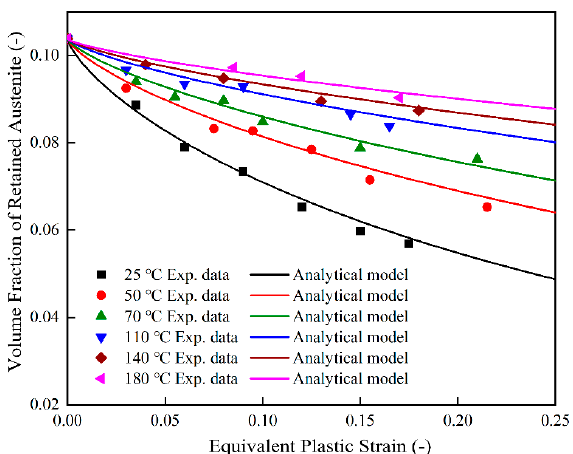
Figure 4. Comparisons of model prediction results of retained austenite evolution at various deformation temperatures.